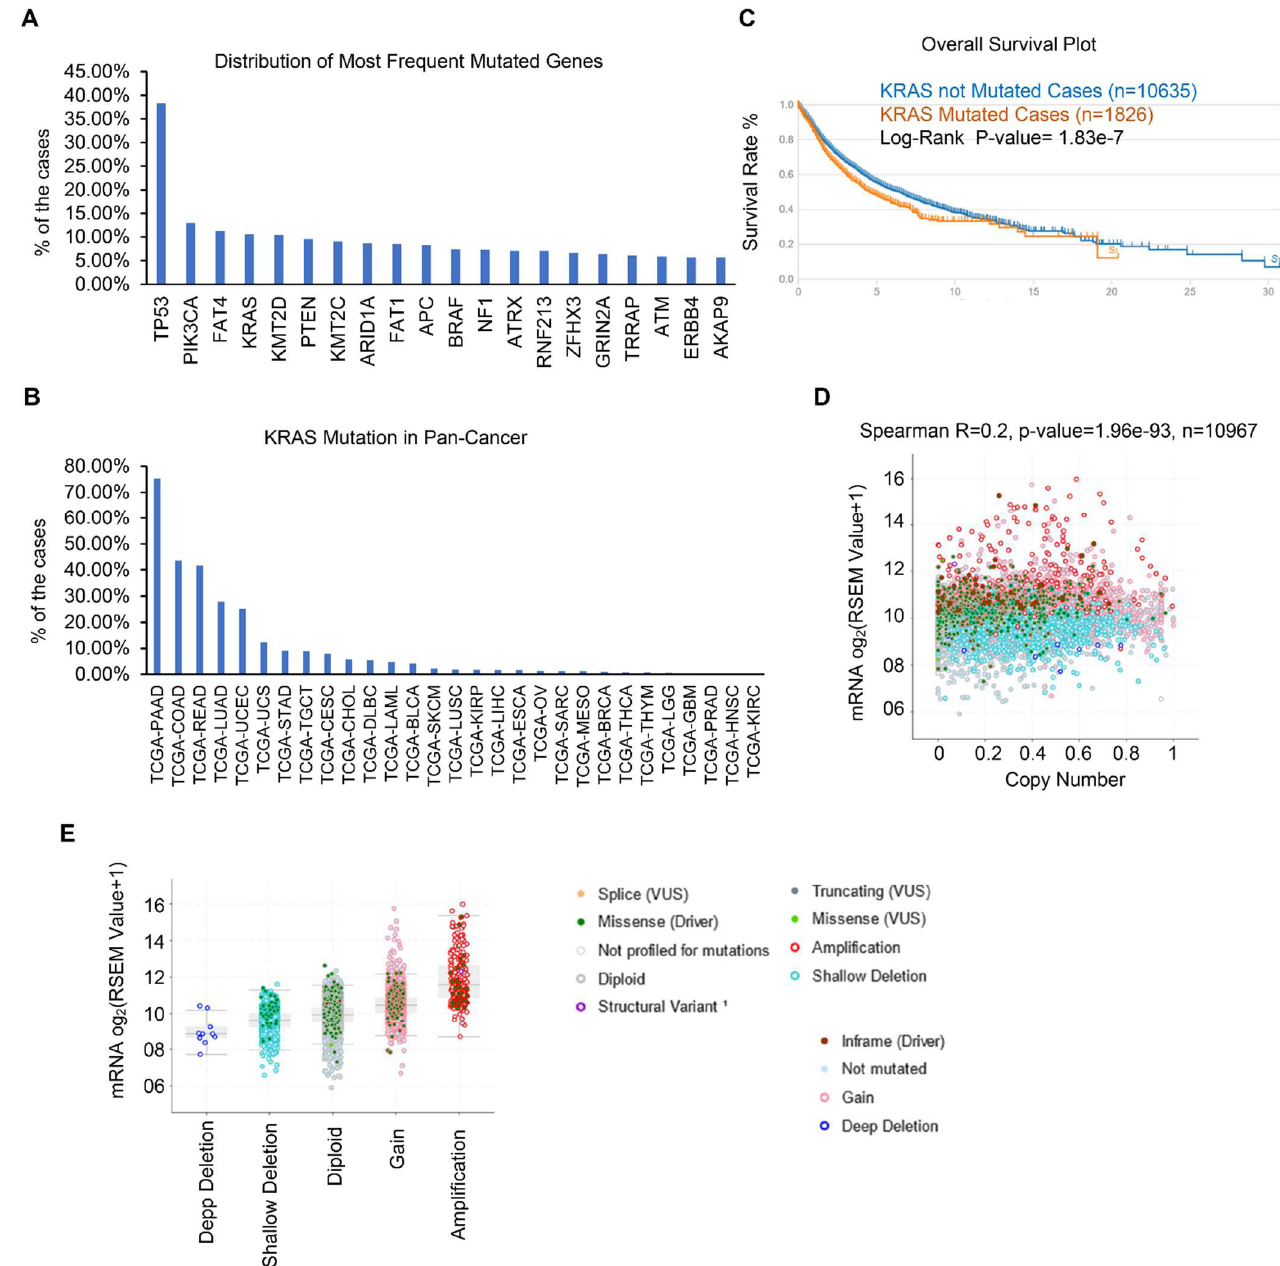
Figure 1. KRAS is frequently mutated in different cancer types. ( A ) Top 20 frequently mutated genes in different cancer types. ( B ) Frequency of KRAS mutations in various cancer types. ( C ) Survival blot showing the correlation between clinical outcomes and KRAS mutations. ( D ) Correlation between KRAS copy number and KRAS mRNA level in TCGA cohorts. ( E ) KRAS is highly expressed in KRAS amplification and gain cohorts than in deep deletion and shallow deletion tumor